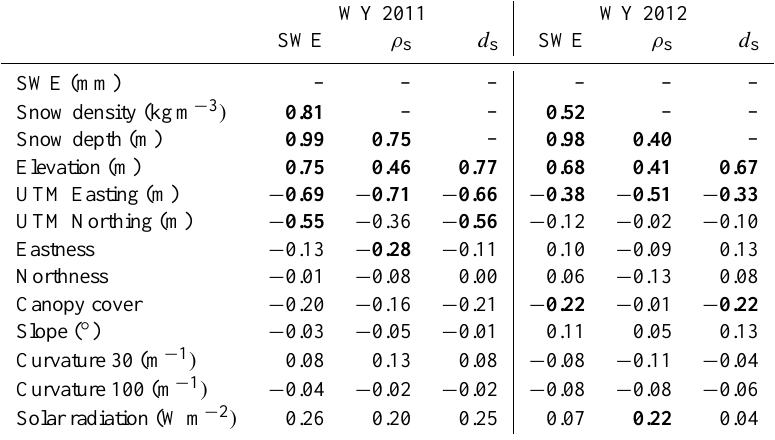
Table 3. Bivariate correlations between SWE, snow density, snow depth, and terrain and canopy variables for the water year 2011 and 2012 snow surveys. Bolded values represent statistical significance ( p value<0.05).